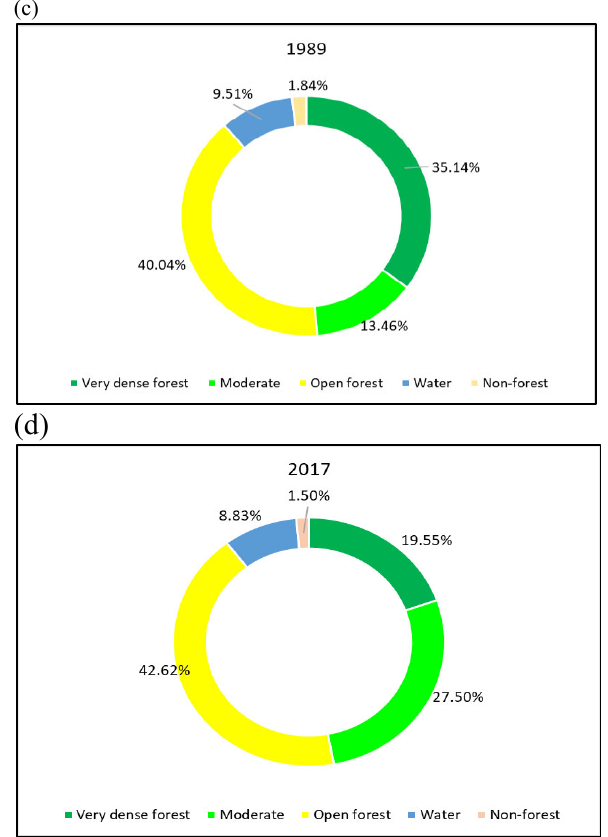
Fig.2 Change in vegetation cover types between (a)1989 and (b) 2017 in the buffer. Percentage of change in different forest cover types during (c)1989 and (d) 2017